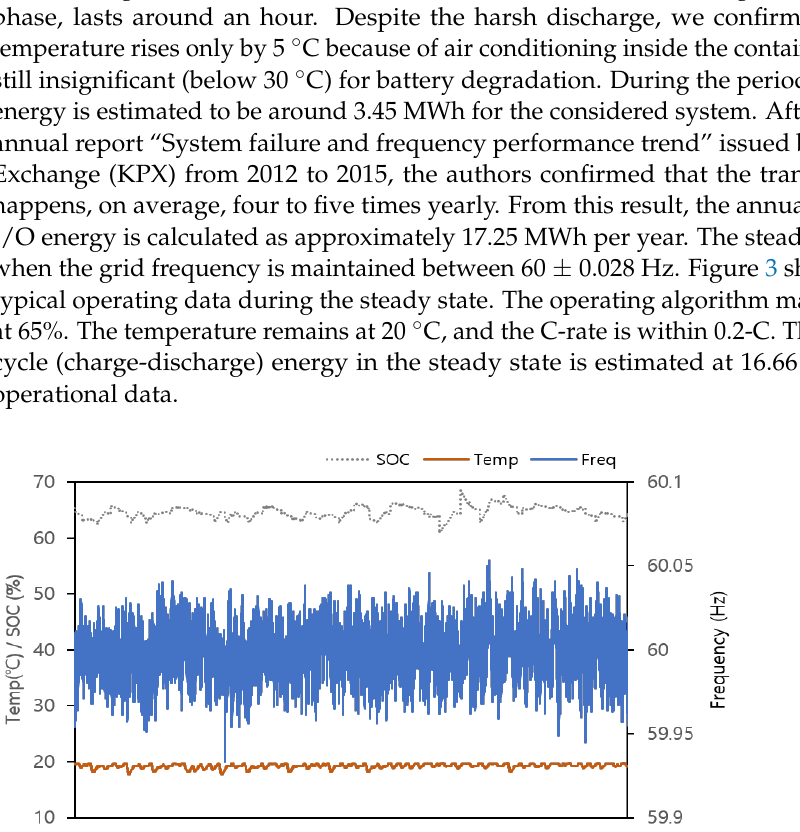
Figure 4. Typical operation profile for the FR BESS transient state.